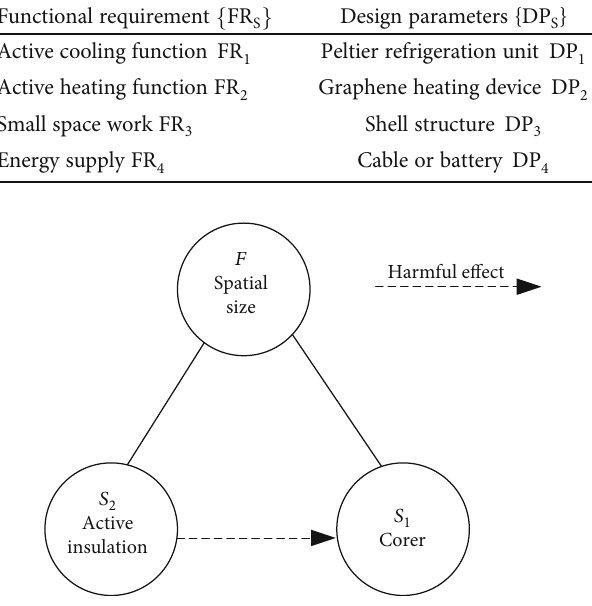
Figure 4: The material fi eld model of the active insulation